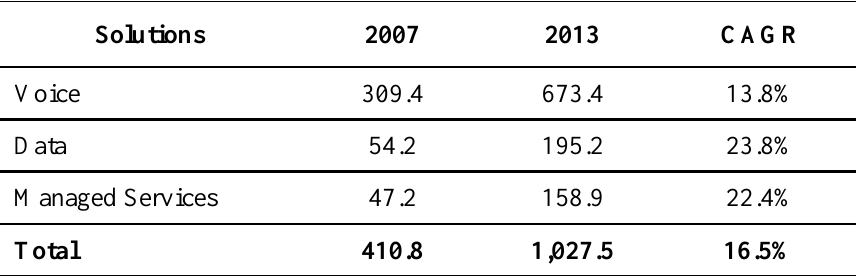
Table 1: Consumer market overview